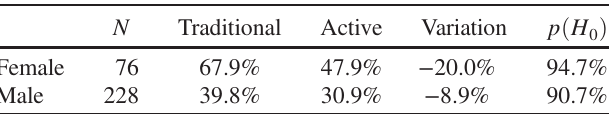
TABLE I. Failure rate in introductory physics as a function of gender. p ð H O Þ is the probability that failure rates decrease by introducing active